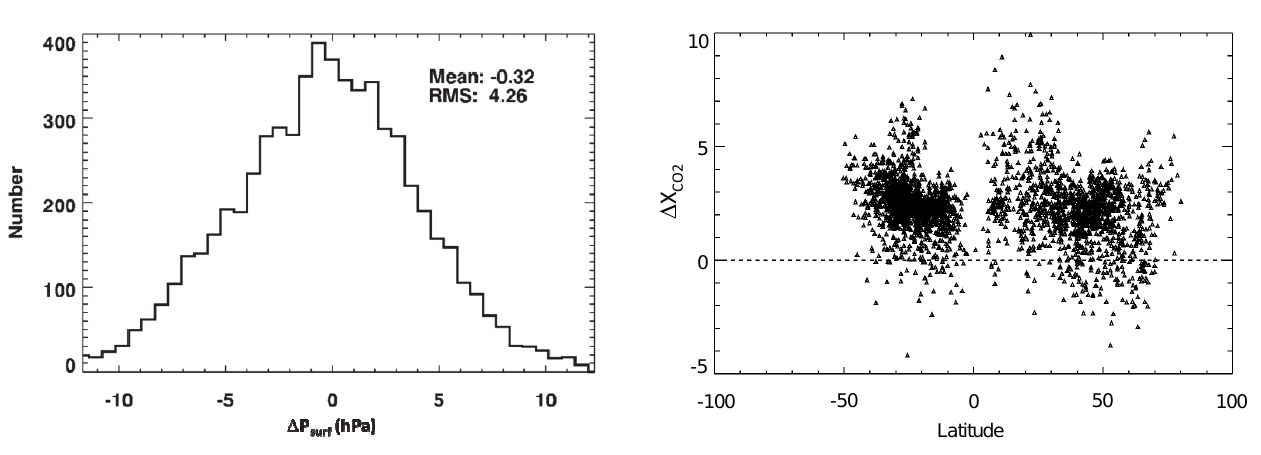
Fig. 15. Increase in X CO produced by correcting the ILS interpo- 2 lation error recently identified in the